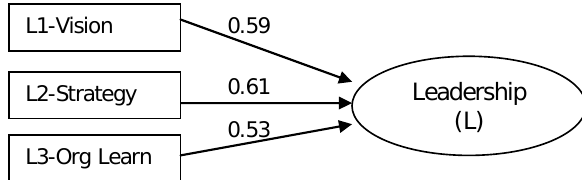
Figure 2: Relative weights of the Leadership